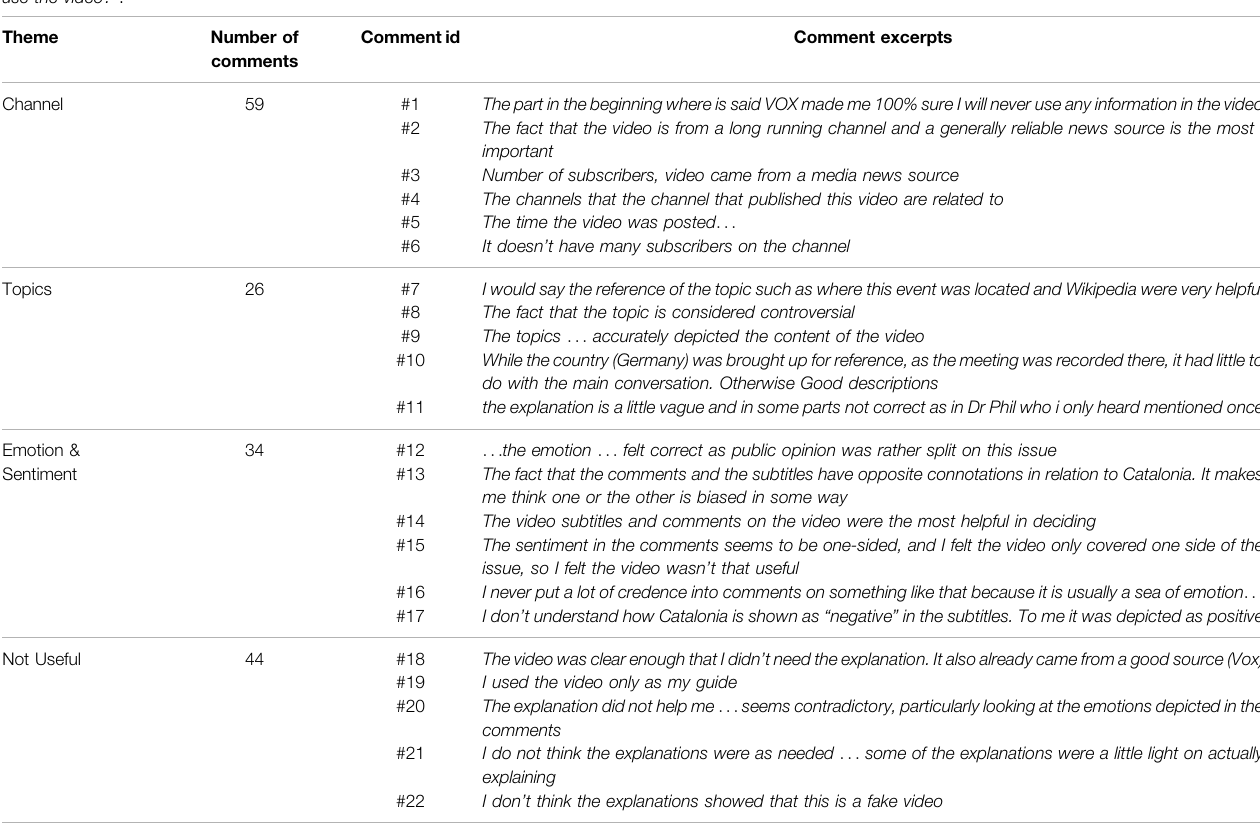
TABLE7| Exampleofcommentsgivenbyparticipantsintheuserstudy,whenaskedthequestion: “ Whichpartsoftheexplanations(ifany)helpedyouthinkaboutwhetherto use the video? ”